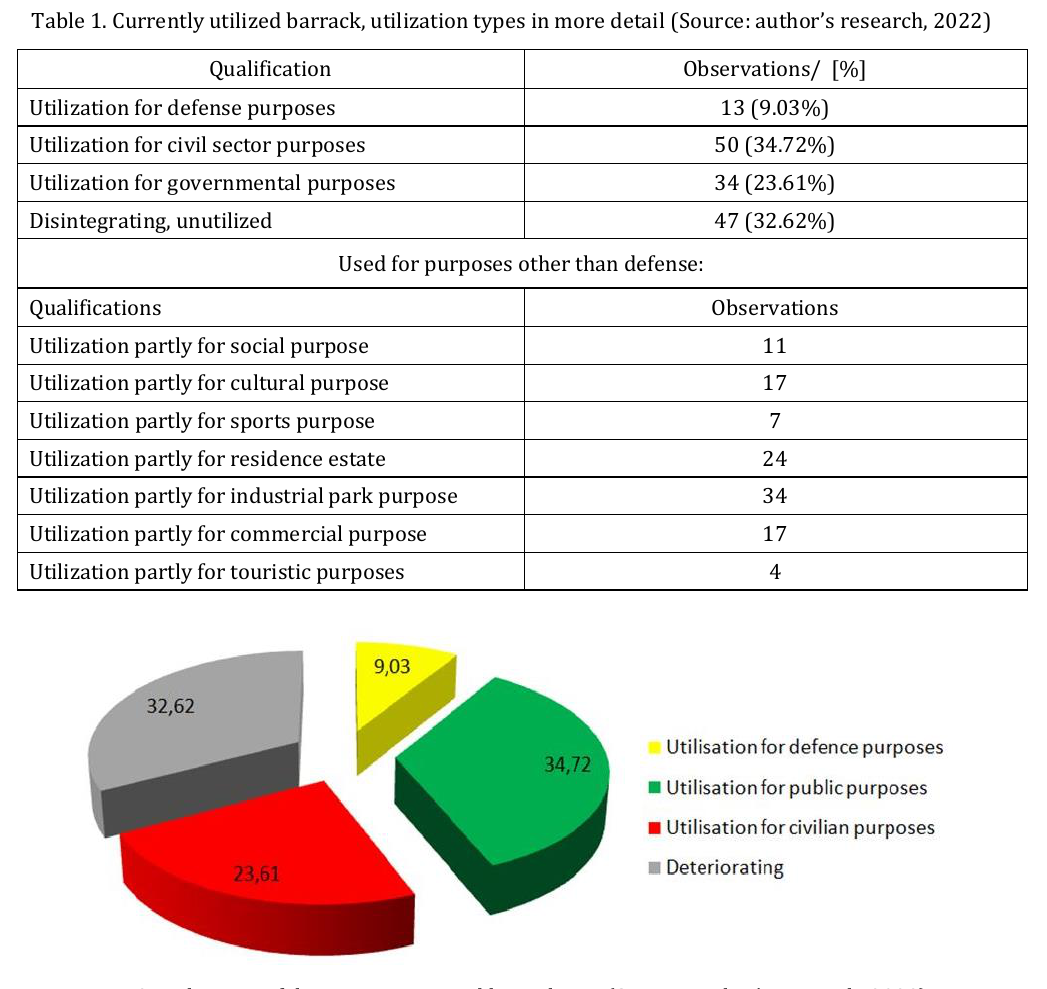
Fig. 2. Utilization of the garrisons visited by author II (Source: author’s research, 2022) Proportion of garrisons without Budapest.